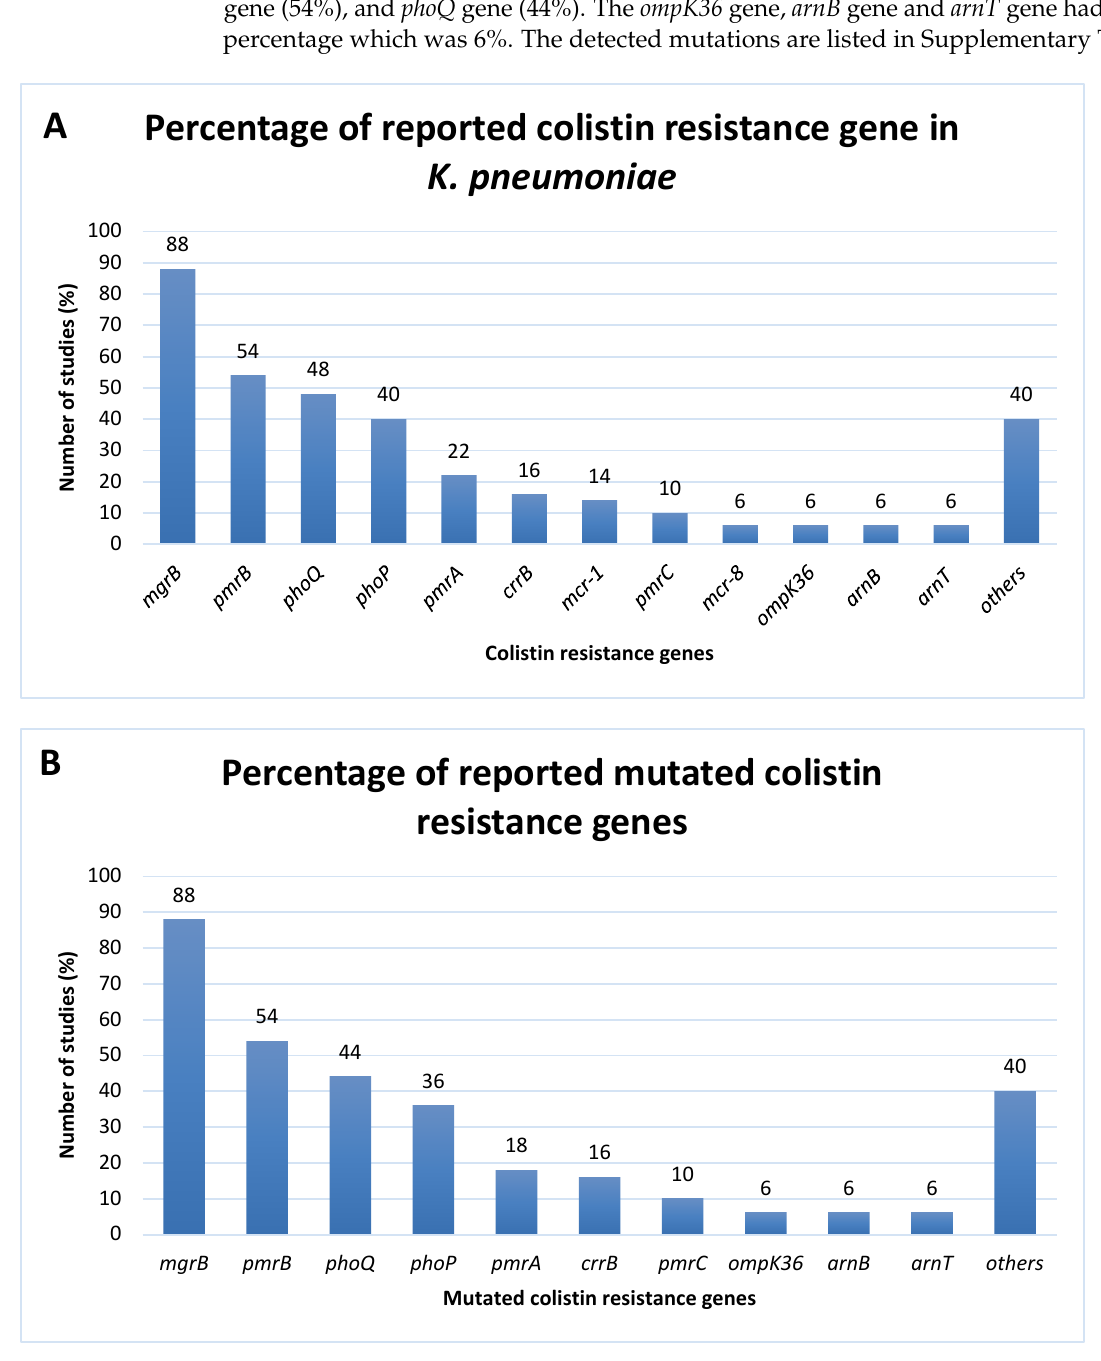
Figure 2. The percentage of reported ( A ) colistin resistance genes and ( B ) mutated colistin resistance genes. Others: acrS , arnA , arnC , crrA , ompK35 , ompK37 , pagP , phoR , pmrE , pmrF , pmrJ , pmrK and ramR .